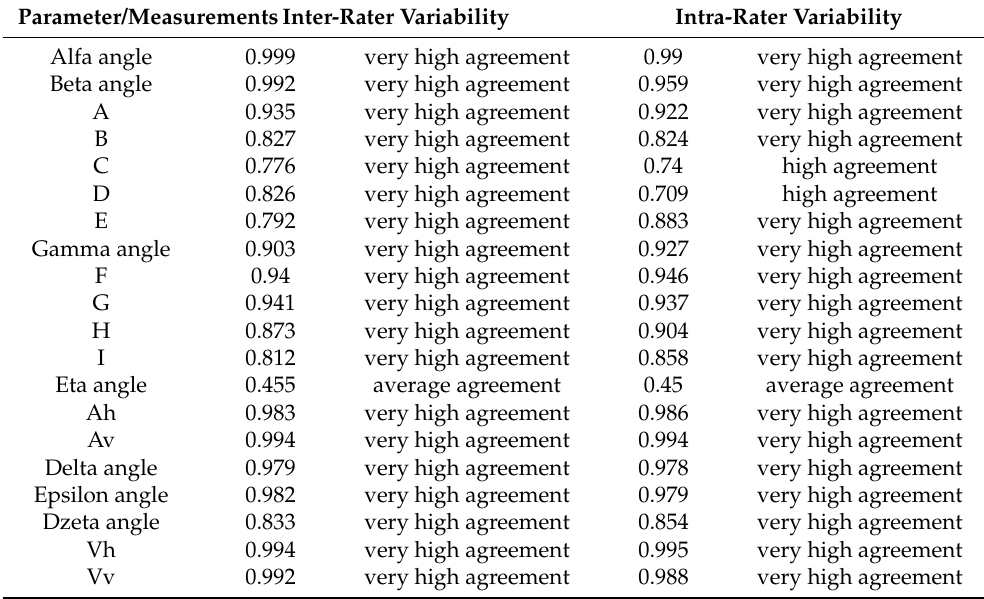
Table 4. Evaluation of reliability/repeatability of measurements using